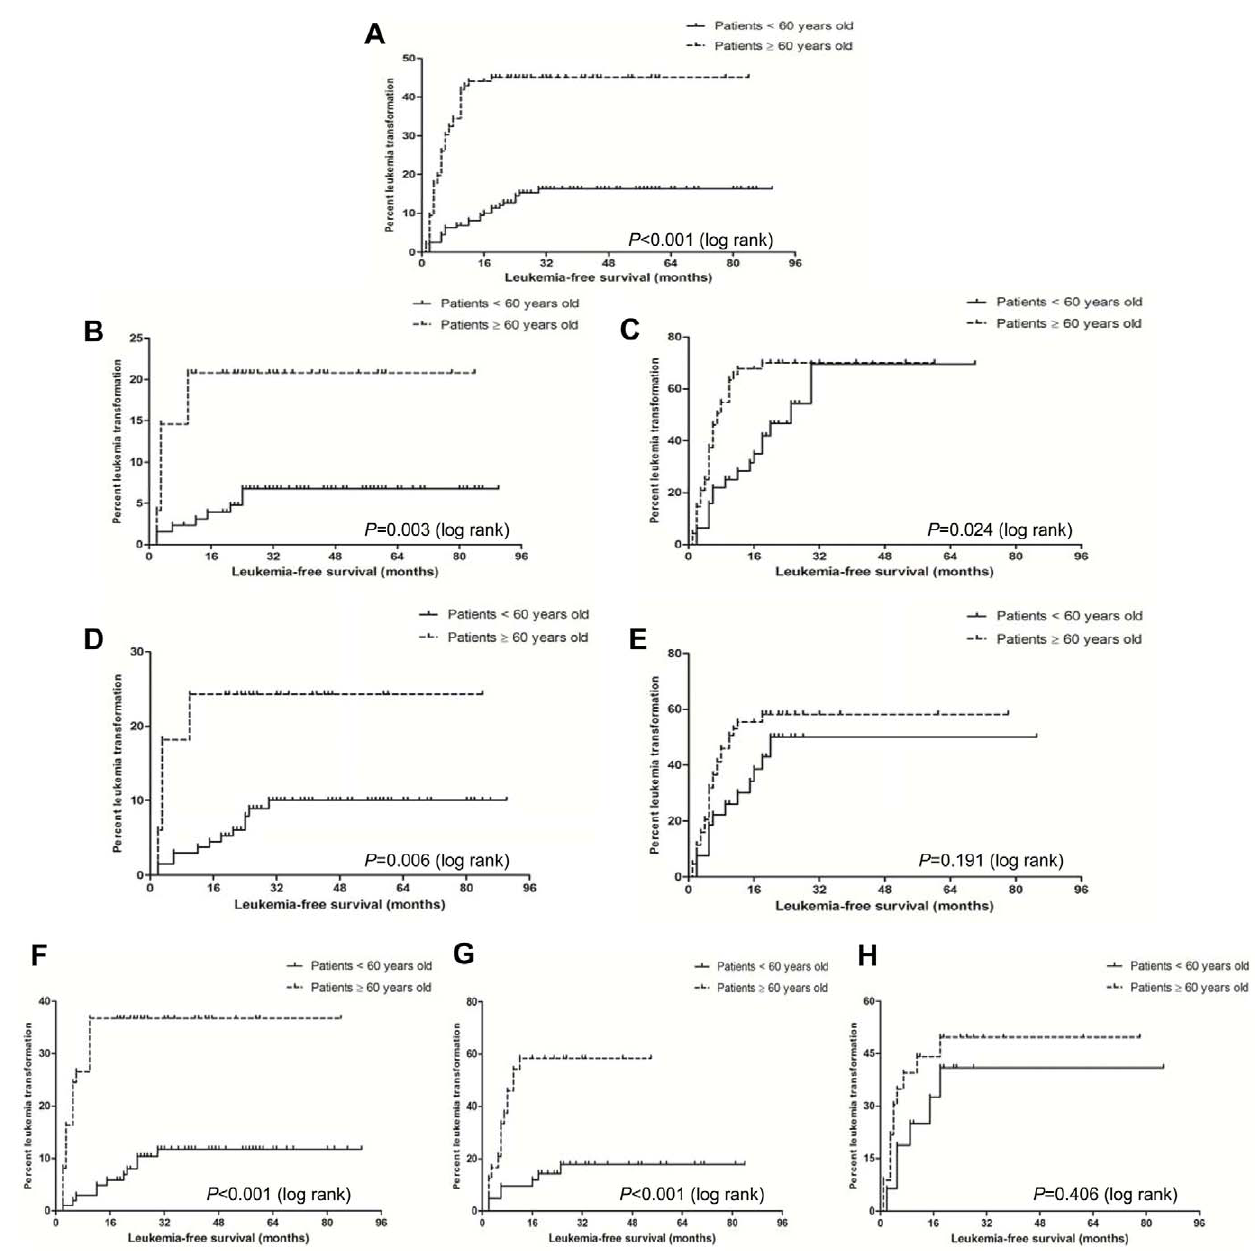
Figure 4. Comparison of LFS between the younger patients and the older ones with MDS. The younger ones had significantly longer LFS than the older ones ( P , 0.001) ( A ). According to WHO classification, whether the younger patients with less advanced ( B ) or advanced MDS ( C ) had significantly longer LFS than the older ones with less advanced or advanced MDS ( P =0.003; P =0.024). According to IPSS grouping, the younger patients with lower-risk had significantly longer LFS than the older ones with lower-risk ( P= 0.006) ( D ). However, there is no difference in LFS between the younger and the older patients with higher-risk ( P= 0.191) ( E ). According to karyotype prognosis grouping, whether the younger patients with good ( F ) or intermediate ( G ) karyotype had significantly longer LFS than the older ones with good or intermediate karyotype ( P , 0.001; P , 0.001). However, there is no difference in LFS between the younger and older ones with poor karyotype ( P= 0.406) ( H ). doi:10.1371/journal.pone.0057392.g004 showed increased ratio of lymphocytes subsets (high percentage of the younger and the older ones (29.0 6 8.5 VS 34.9 6 9.7, P = 0.154). After removal of activated CD4 + T cells, the younger Tc1 and NK cells) which may target towards tumor cells than that in the younger patients, the removal of activated T lymphocytes patients showed significantly higher colony formation than the did not caused increased colony formation of hematopoietic cells older ones (38.1 6 9.4 VS 25.0 6 8.6, P = 0.001). Similarly, the in the older patients. younger patients showed significantly higher colony formation than the older ones after removal of activated CD8 + T cells (48.2 6 9.5 VS 34.6 6 9.2, P =0.001). Although the older patients